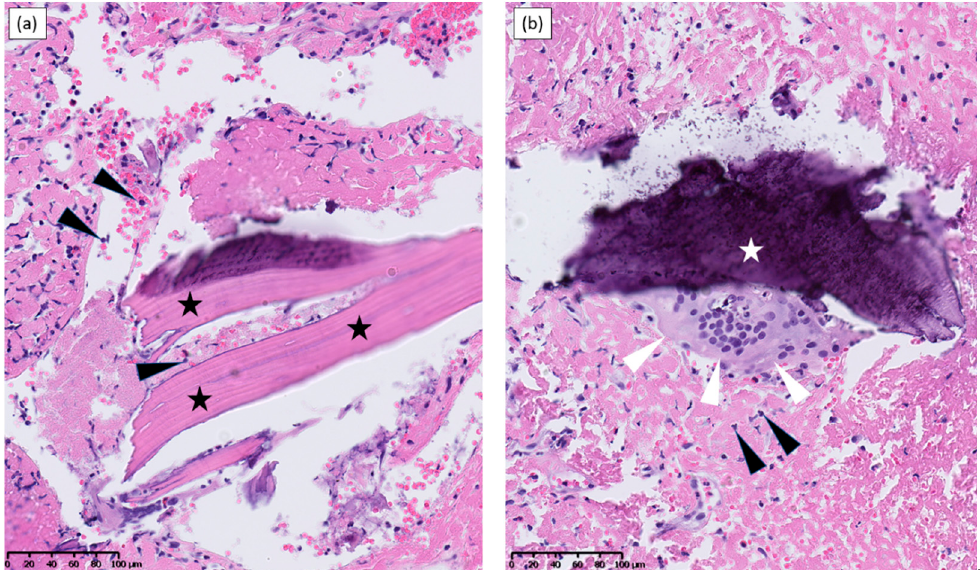
Figure 2. Pathological findings from pelvic bone allograft biopsies obtained upon infection recurrence, six months after phage therapy has been discontinued. ( a ) Lamellar bone fragments (stars) appear necrotic, displaying only empty osteocyte lacunae; immediate surroundings are infiltrated with inflammation-inducing figurative elements of blood with numerous leucocytes (arrows). ( b ) Necrotic bone fragment (star) is lysed by a massive osteoclast (white arrows). Immediate surroundings are again infiltrated with numerous leucocytes (black arrows).